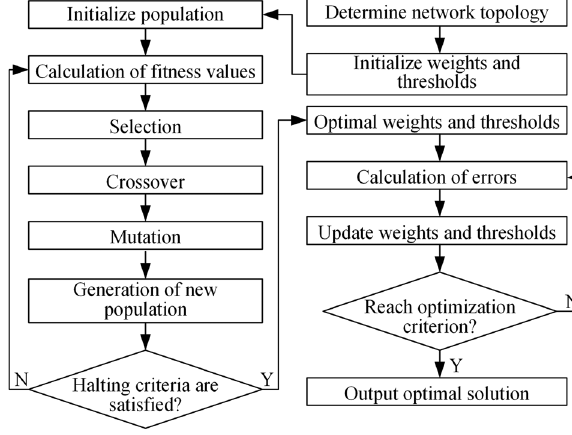
Figure 3: The procedure of using GA to optimize BP